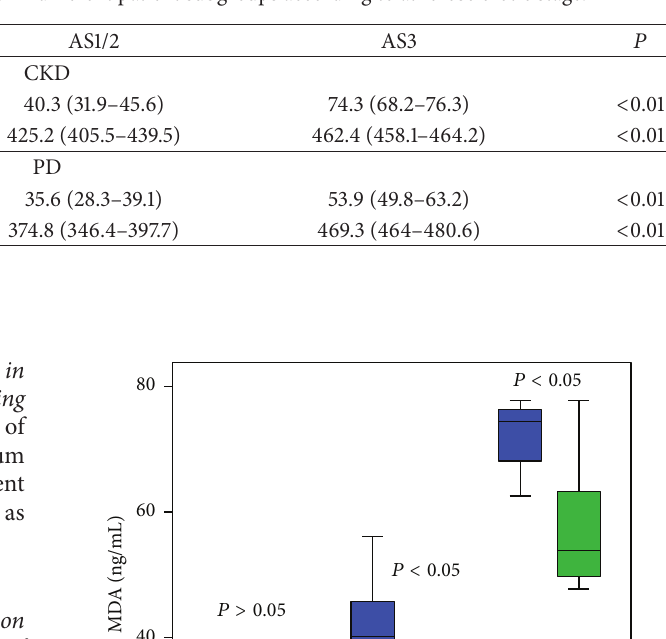
Table 2: The serum concentration of MDA and MMP-9 in different patient subgroups according to atherosclerotic stage.